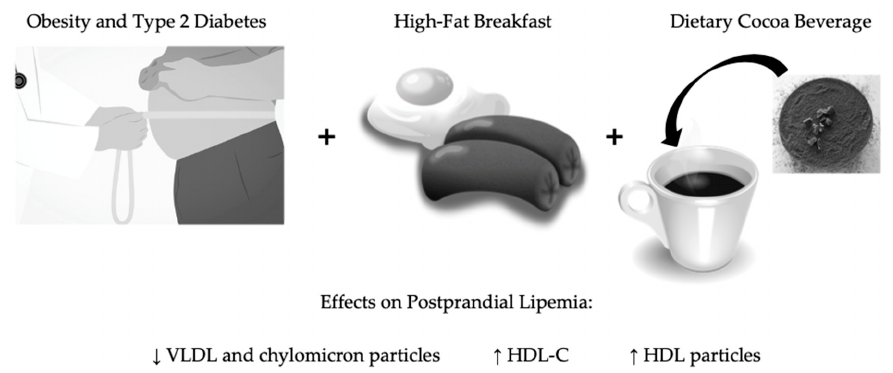
Figure 1. Effects of acute polyphenol-rich cocoa supplementation on postprandial lipemia after a fast-food-style, high-fat Western breakfast in adults with obesity and type 2 diabetes. VLDL: very low-density lipoprotein; HDL-C: high density lipoprotein cholesterol; HDL-P: high-density lipoprotein